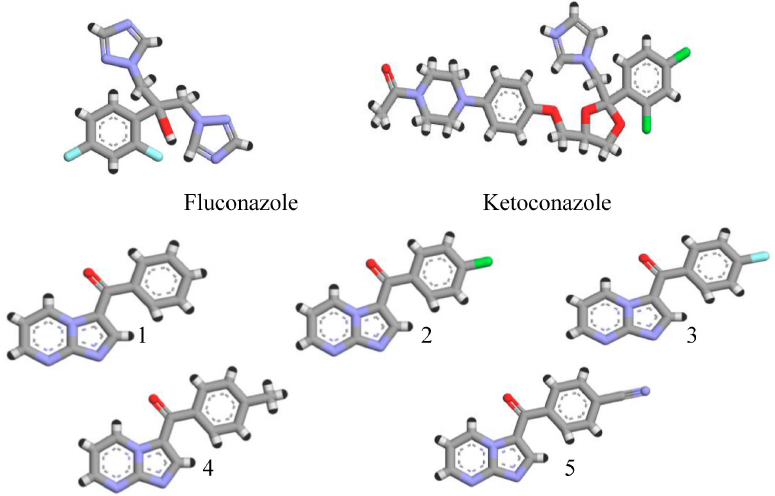
Figure 5. 3D representation of the compounds used for biological activity and molecular